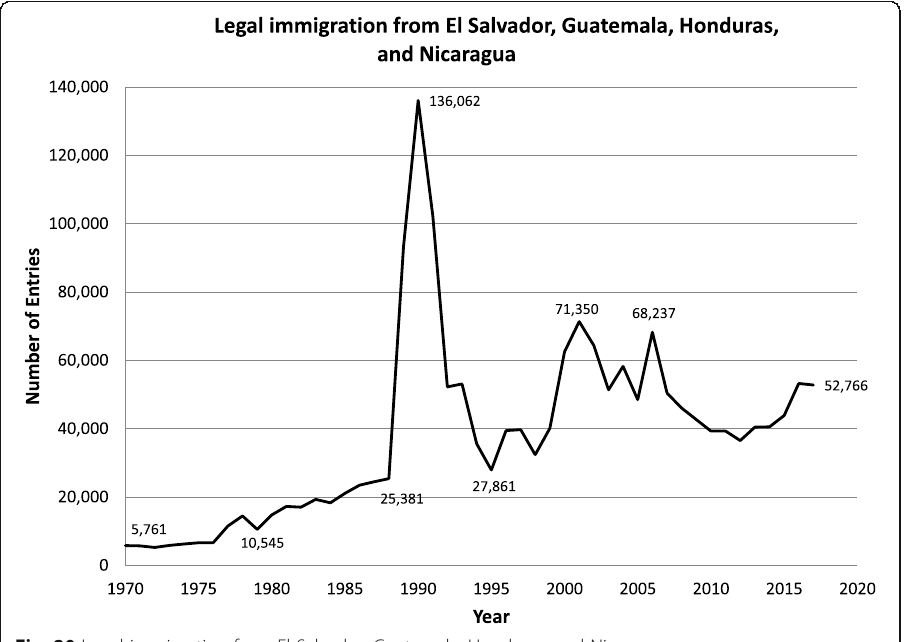
Fig. 20 Legal immigration from El Salvador, Guatemala, Honduras, and Nicaragua